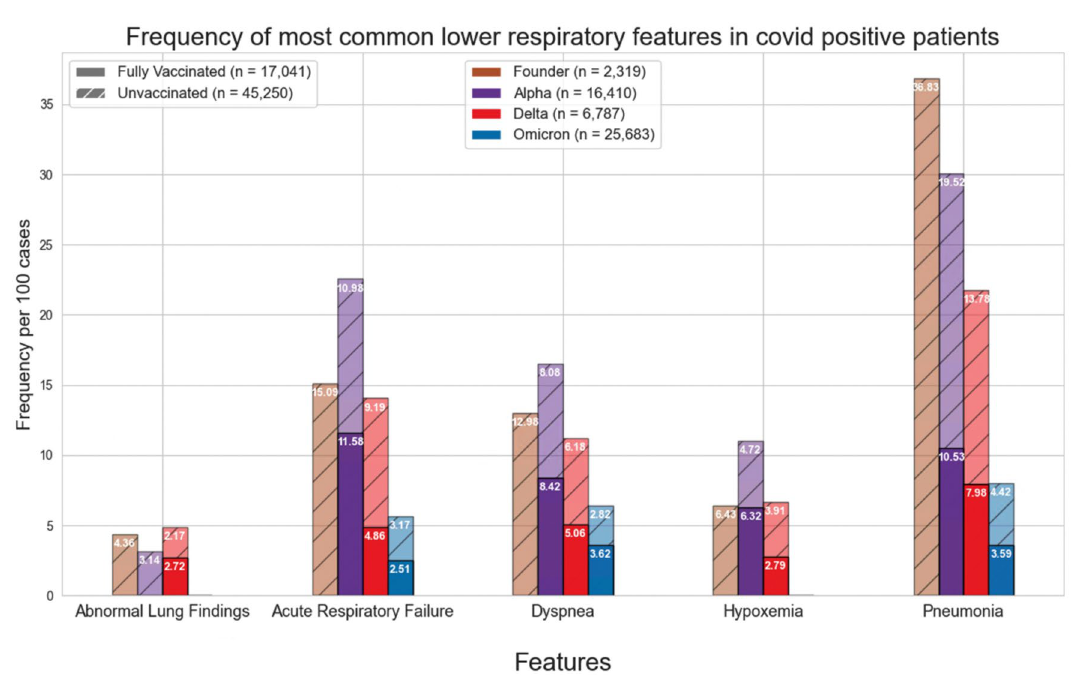
Figure 3. Comparison of frequency of most common lower respiratory features in COVID positive patients based on fully vaccinated or unvaccinated